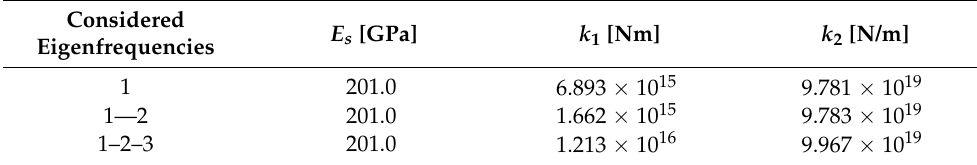
Table 8. Different variation ranges and optimal values of the unknown parameters for the can- tilever beam case. Optimal solution with different number of eigenfrequencies considered in the target